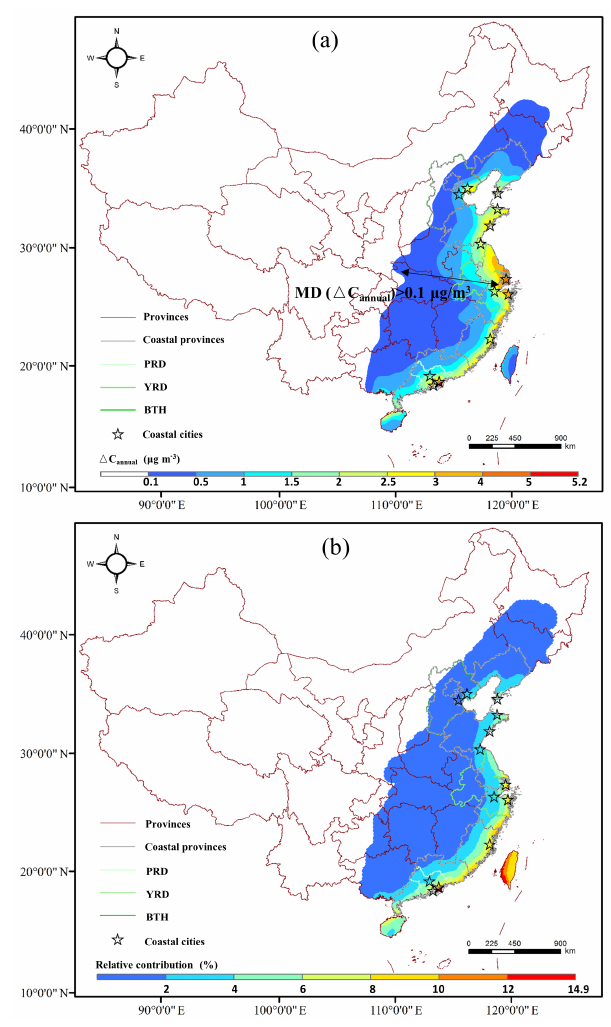
Figure 3. Contributions of shipping emissions to the annual mean PM 2 . 5 concentrations, including (a) absolute contributions (base case – no ship case) and (b) relative differences (relative to the base case concentrations).